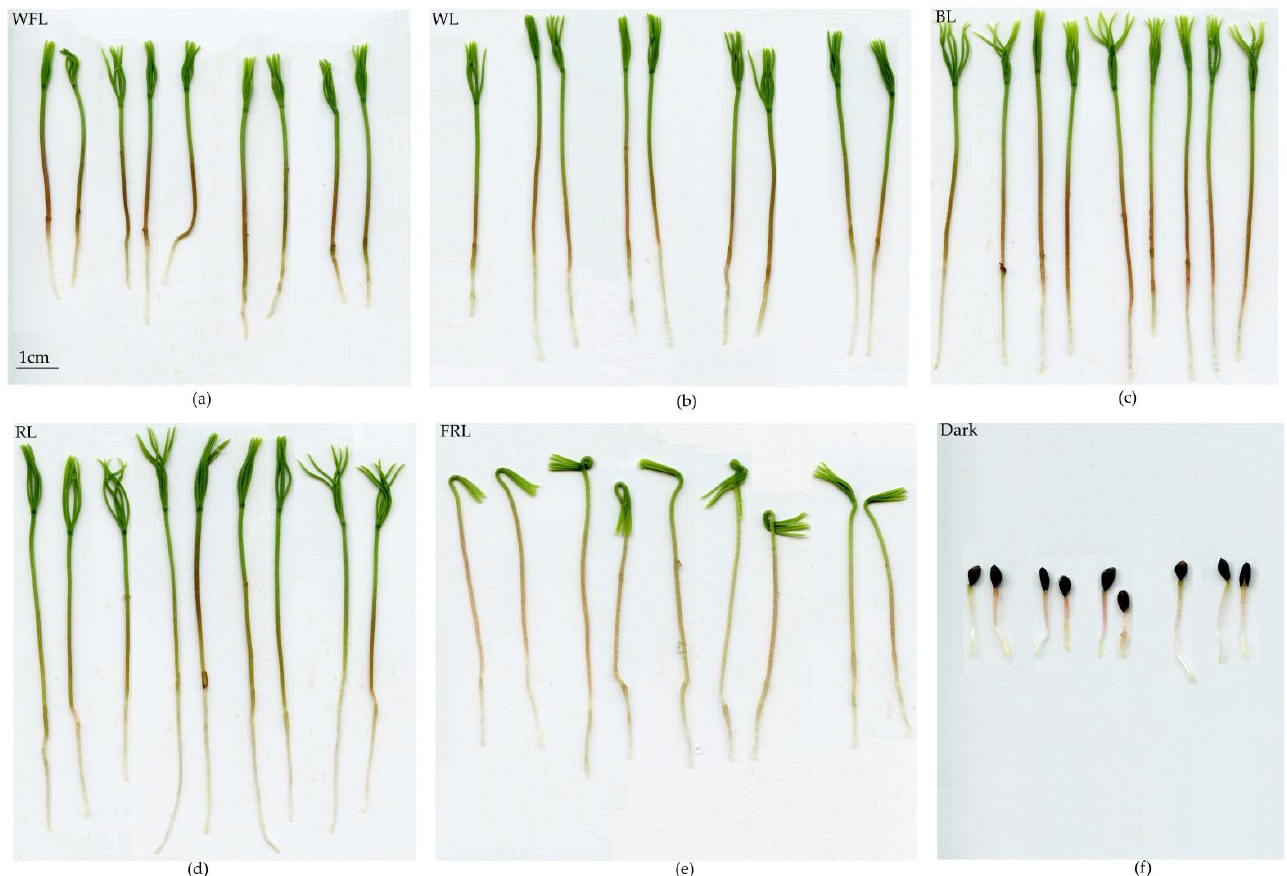
Figure 2. Nine-day-old Scots pine plantlets grown under different light regimes: ( a ) WFL; ( b ) WL; ( c ) BL; ( d ) RL; ( e ) FRL; ( f ) Dark. Table 2. Growth parameters of Scots pine plantlets on the 9th day of the experiment under different light and dark